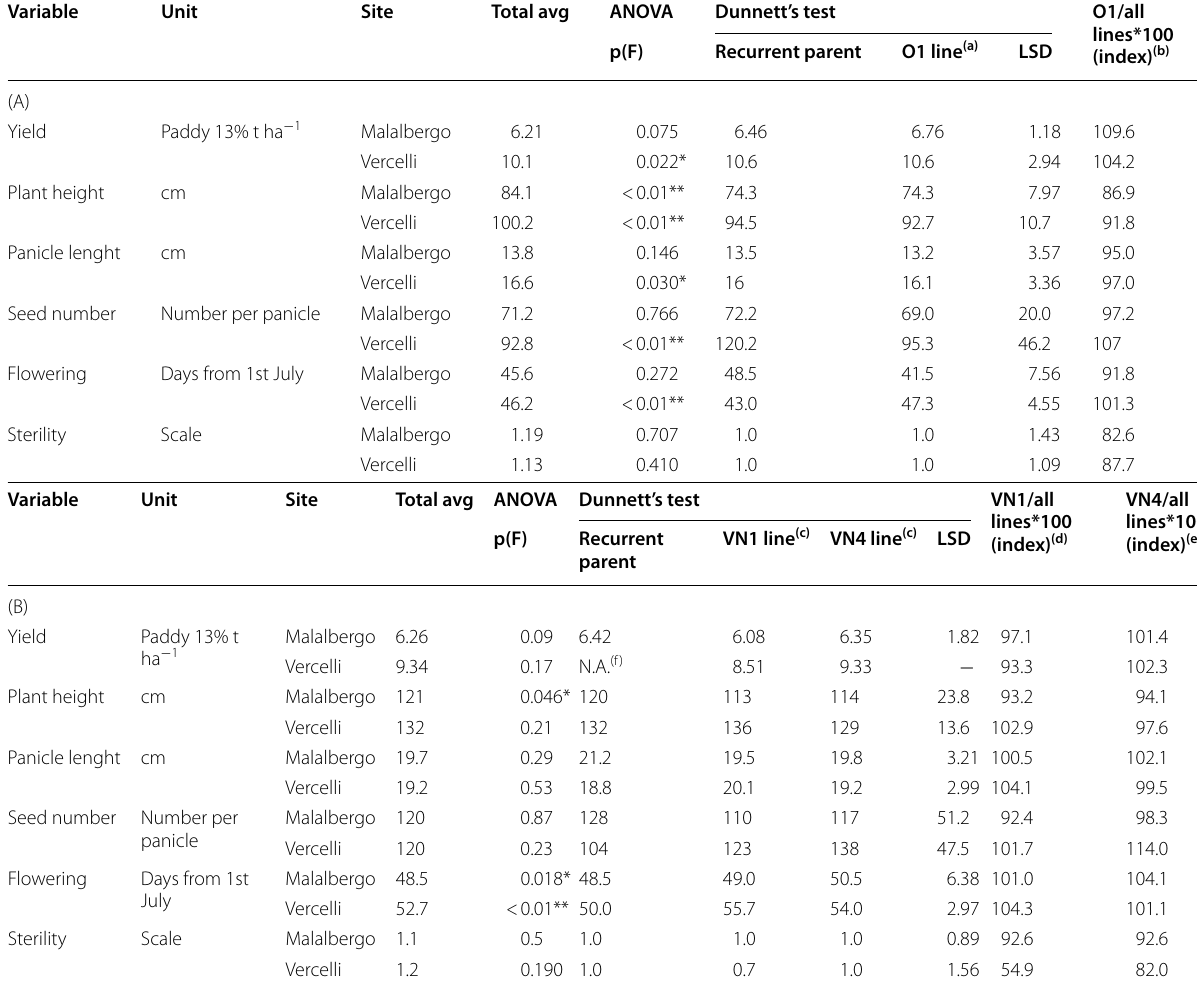
Table 4 The results and statistics of phenotypic evaluations of BC introgression lines and the recurrent parent Vialone Nano (B), tested in two experimental sites (Malalbergo and Vercelli). ANOVA and Dunnett’s test significant for p(F) <